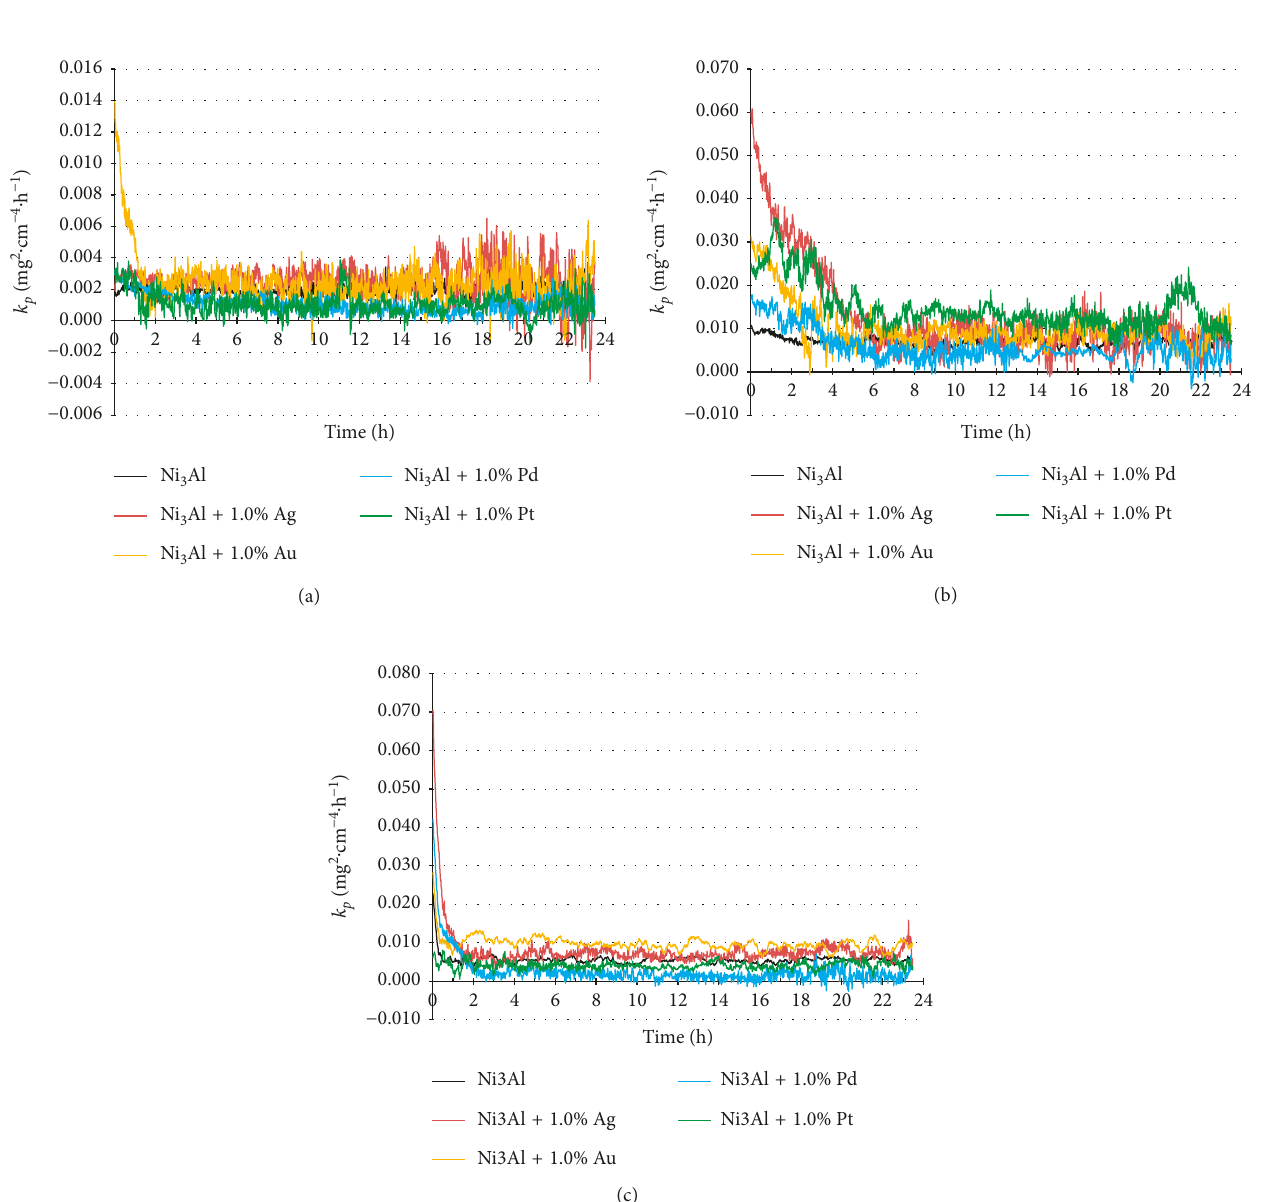
Figure 6: Instantaneous k p versus time for the intermetallic alloys oxidized at (a) 900 Table 4: Average values of instantaneous k